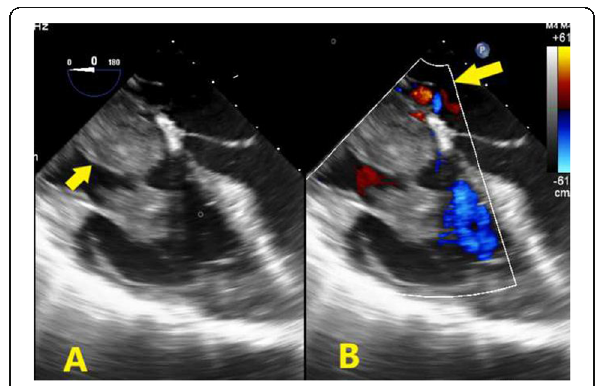
Fig. 3 a Trans-esophageal two-dimensional echocardiography, mid- esophageal apical 4-chamber view showing a huge right atrial mass filling the whole cavity of the right atrium oscillating in and out of the right ventricle through the tricuspid valve. b Color Doppler showing patent foramen